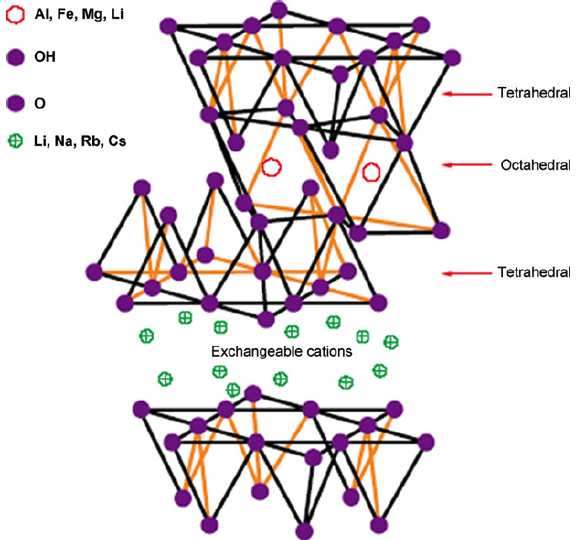
Figure 6. The structure of 2:1 layered silicate (Reprinted with permission from [80]. Copyright 2002